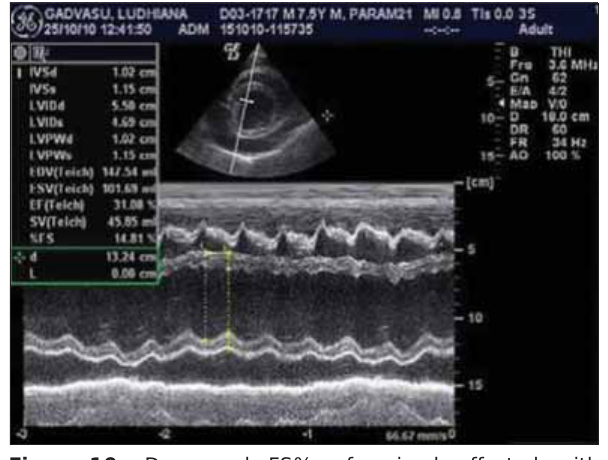
Figure-10: Decreased FS% of animal affected with combined DCM and PE.